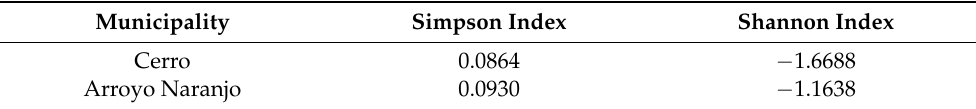
Table 3. Fungal diversity in the municipalities of Cerro and Arroyo